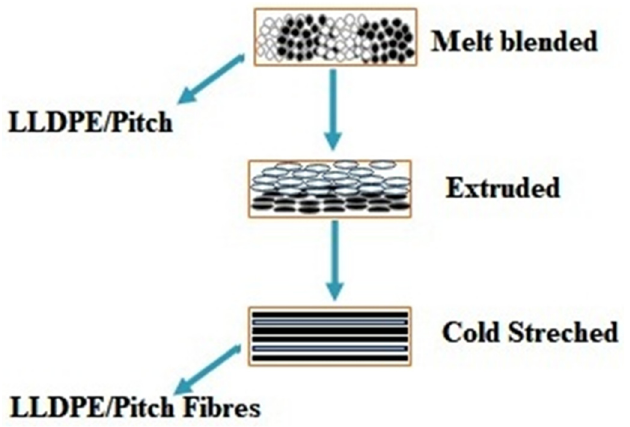
Figure 1. Production of fibres from melt blends . Table 1. Blends in terms of wt% mesophase pitch and LLDPE .